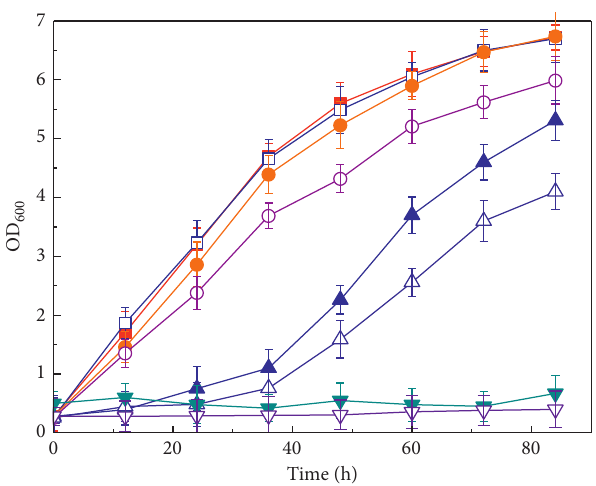
Figure 2: The effect on temperature tolerance of G. oxydans after the expression of CutA. The symbols ■ , ● , ▲ , and ▼ represent the growth curve of G. oxydans /pGUC- tufB - cutA at 30 ° C, 37 ° C, 42 ° C, and 45 ° C, respectively. The symbols □ , ○ , △ , and ▽ represent the growth curve of G. oxydans /pGUC at 30 ° C, 37 ° C, 42 ° C, and 45 ° C, respectively. Error bars represent the standard deviation of three biological replicates.